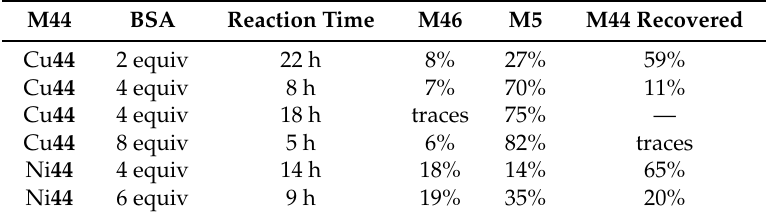
1 Data from ref. [69].